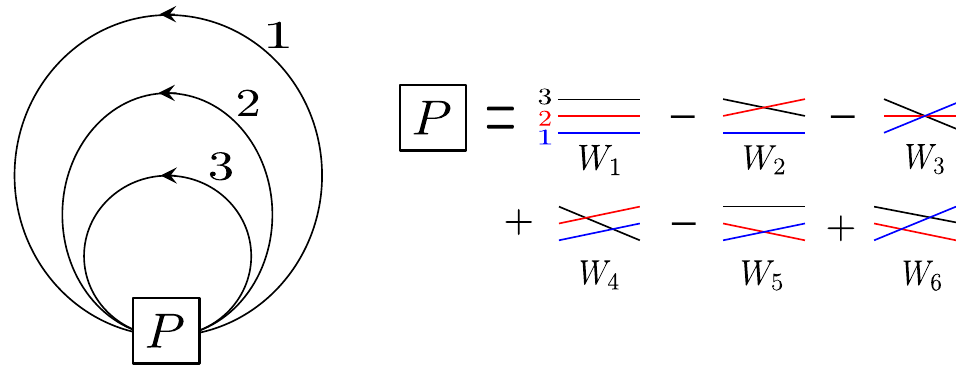
Figure 9. The rank-3 antisymmetric Wilson loop and its generalization can be obtained by taking a linear combination of the intersecting loops W 1 - W 6 . Each W j corresponds to an element of the permutation group S 3